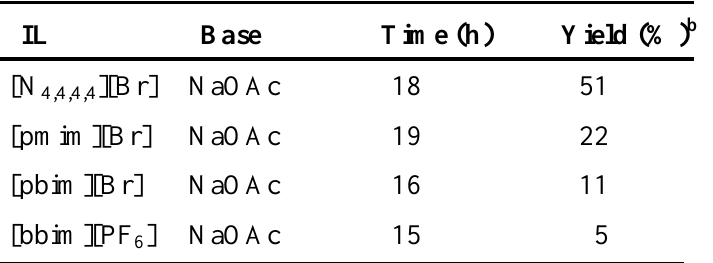
Table 6. Heck reaction of chlorobenzene and styrene in presence of palladacycle X a